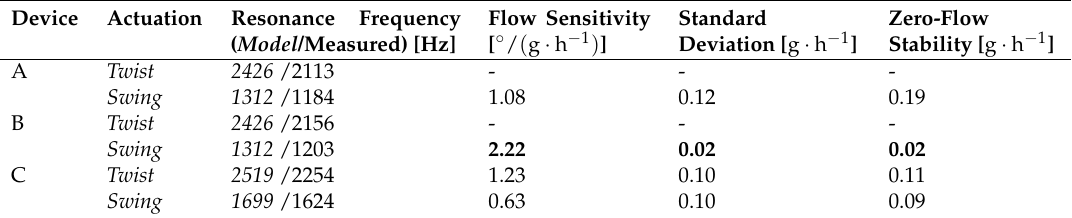
Table 1. Experimental parameters of the three flow sensors determined from the (zero-)flow measurements. The zero-flow stability is defined as the standard deviation of the measured flow over a period of 1800 s (see Figure